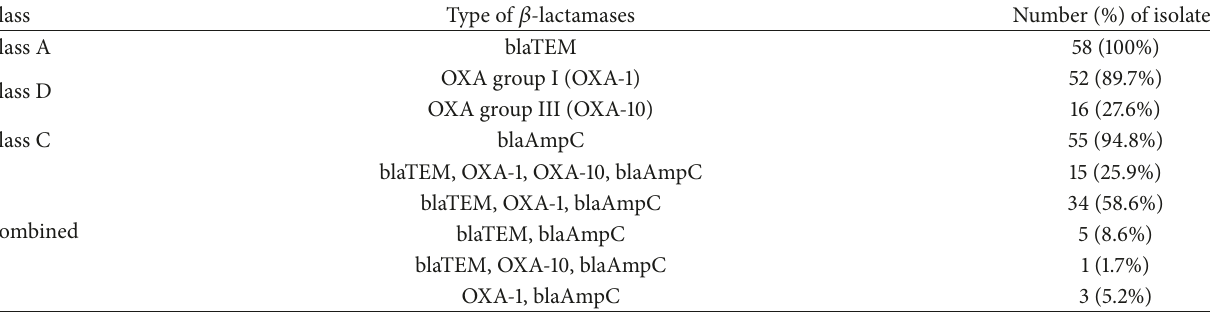
Table 3: Prevalence of Ambler classes A, C, and D 𝛽 -lactamases among fifty-eight clinical isolates of P.